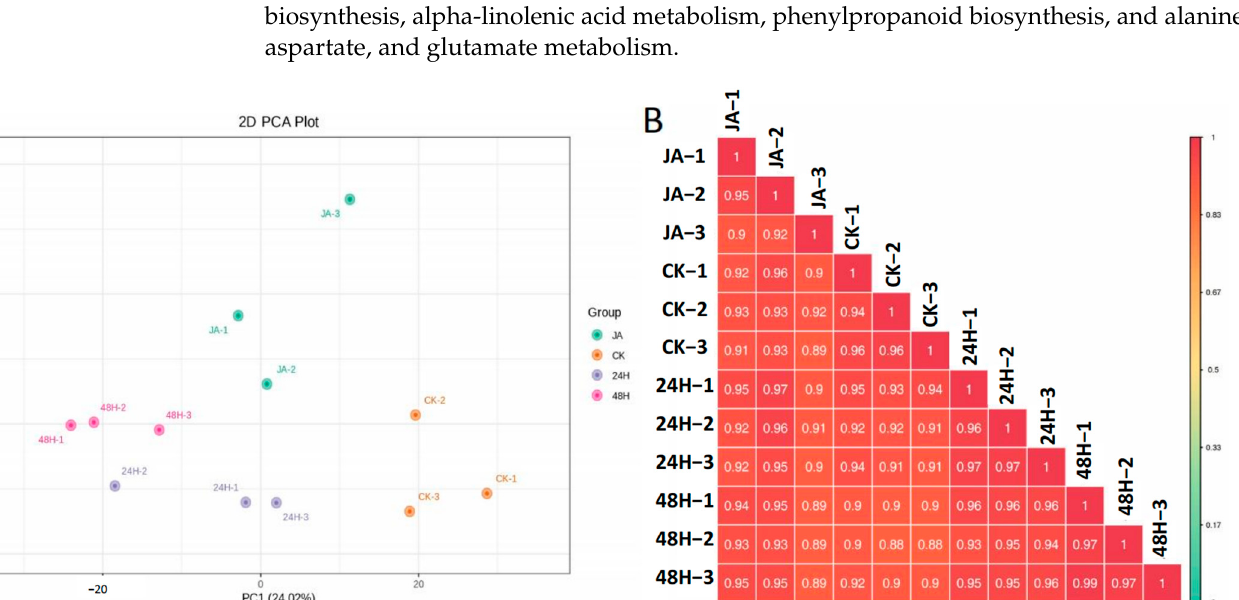
Table 3. Summary of differentially expressed metabolites in different comparisons.